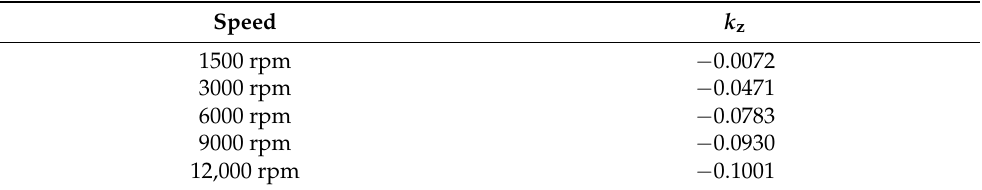
Table 2. Reduction Coefficient.